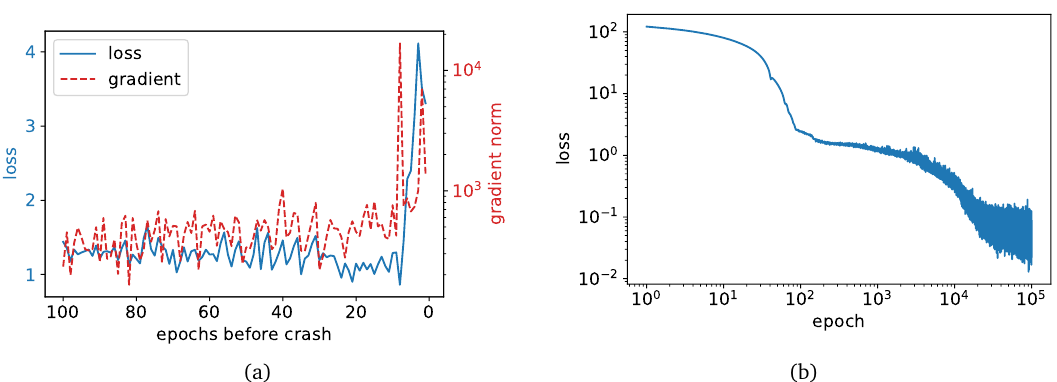
Figure 3: (a) During training, sampling of a region with f ( y ) ≈ 0 leads to a sharp ( w ) | , a subsequent rise in the loss function, and a jump in the gradient norm | ∇ L KL division-by-zero attempt, causing the code to crash. (b) After gradient clipping is introduced, the numerical instability is eliminated and training proceeds smoothly until the minimum of the loss function is